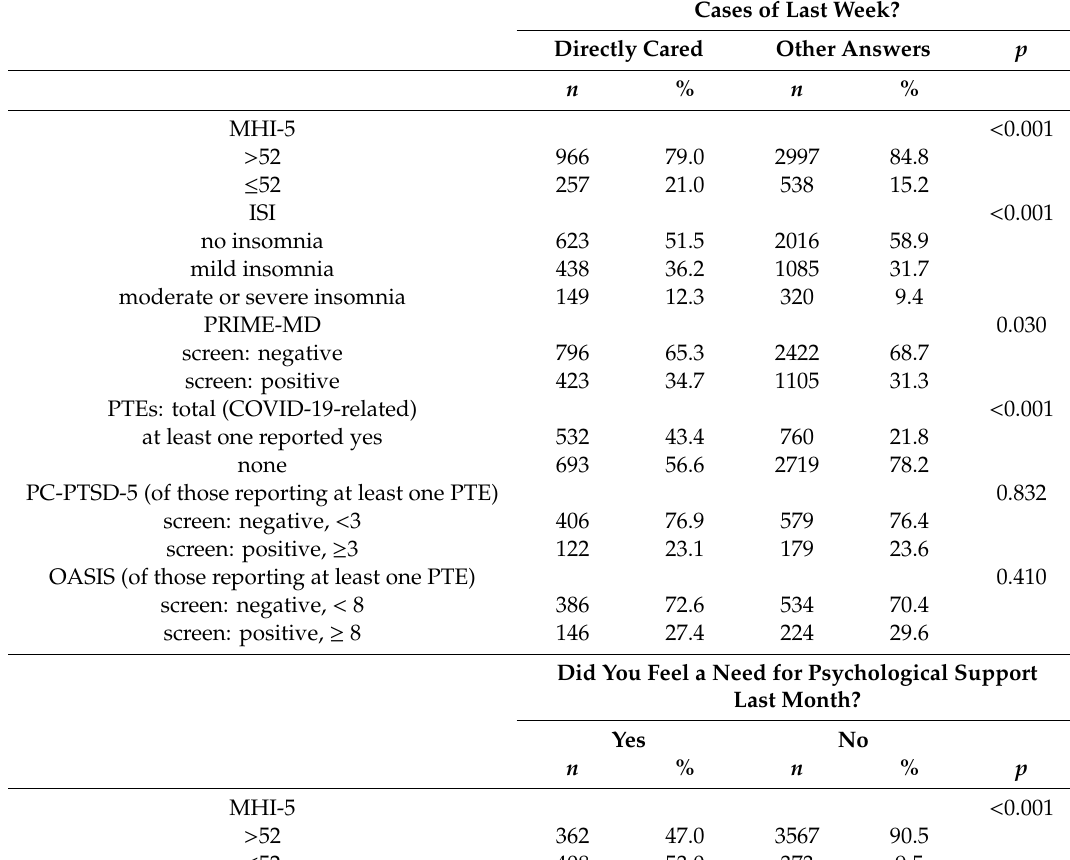
Table 3. Self-reported emotional distress and psychological symptoms among frontline personnel and other HUS personnel participants of the well-being survey in June 2020. Were You in Contact with Confirmed or Suspected Cases of Last